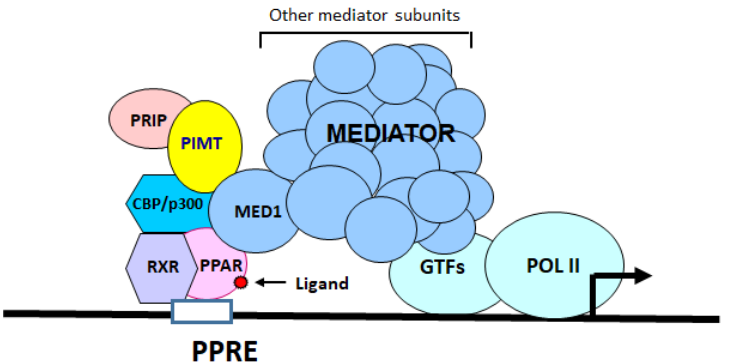
Figure 7. A model showing the interactions of PIMT with PRIP/NCOA6, histone acetyl transferases p300/CBP, and MED1 of the Mediator complex in the regulation of transcription of PPAR regulated genes. Note that in addition to Med1 subunit of the Mediator complex MED30 and MED12 also modulate genes involved in energy metabolism. See Discussion for further details.